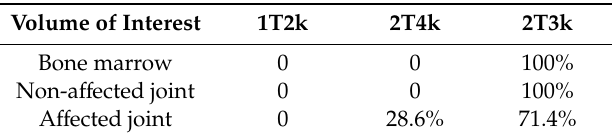
Table 3. Preference for single tissue compartment model (1T2k), irreversible two tissue compartment model (2T3k), and reversible two tissue compartment model (2T4k) models, given in %, for various regions on the basis of the Akaike information criterion.